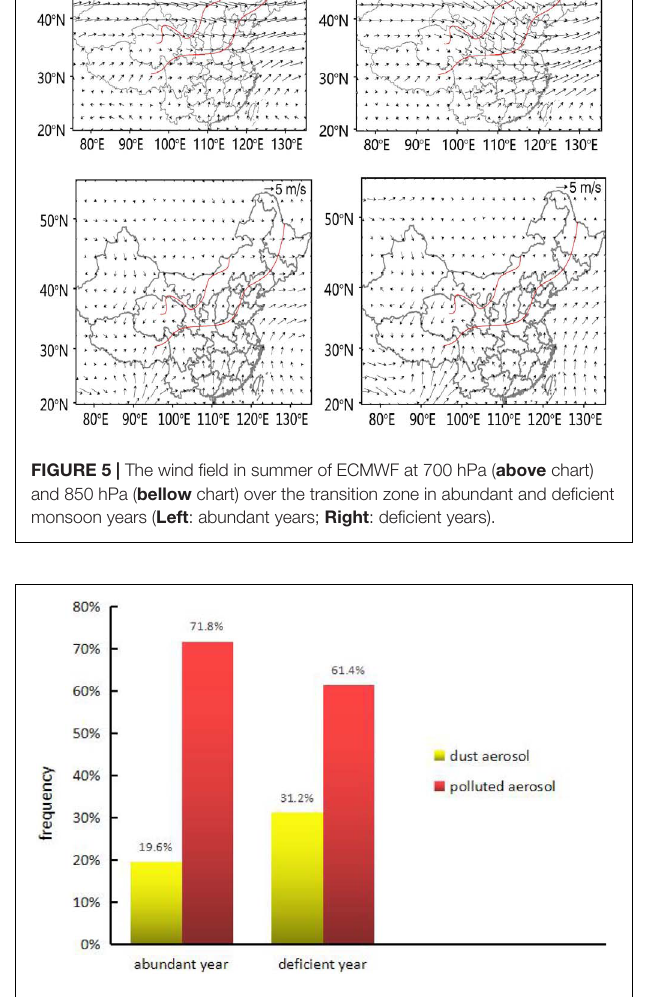
FIGURE 6 | The proportion of dust and polluted aerosols over the transition zone in abundant and deficient